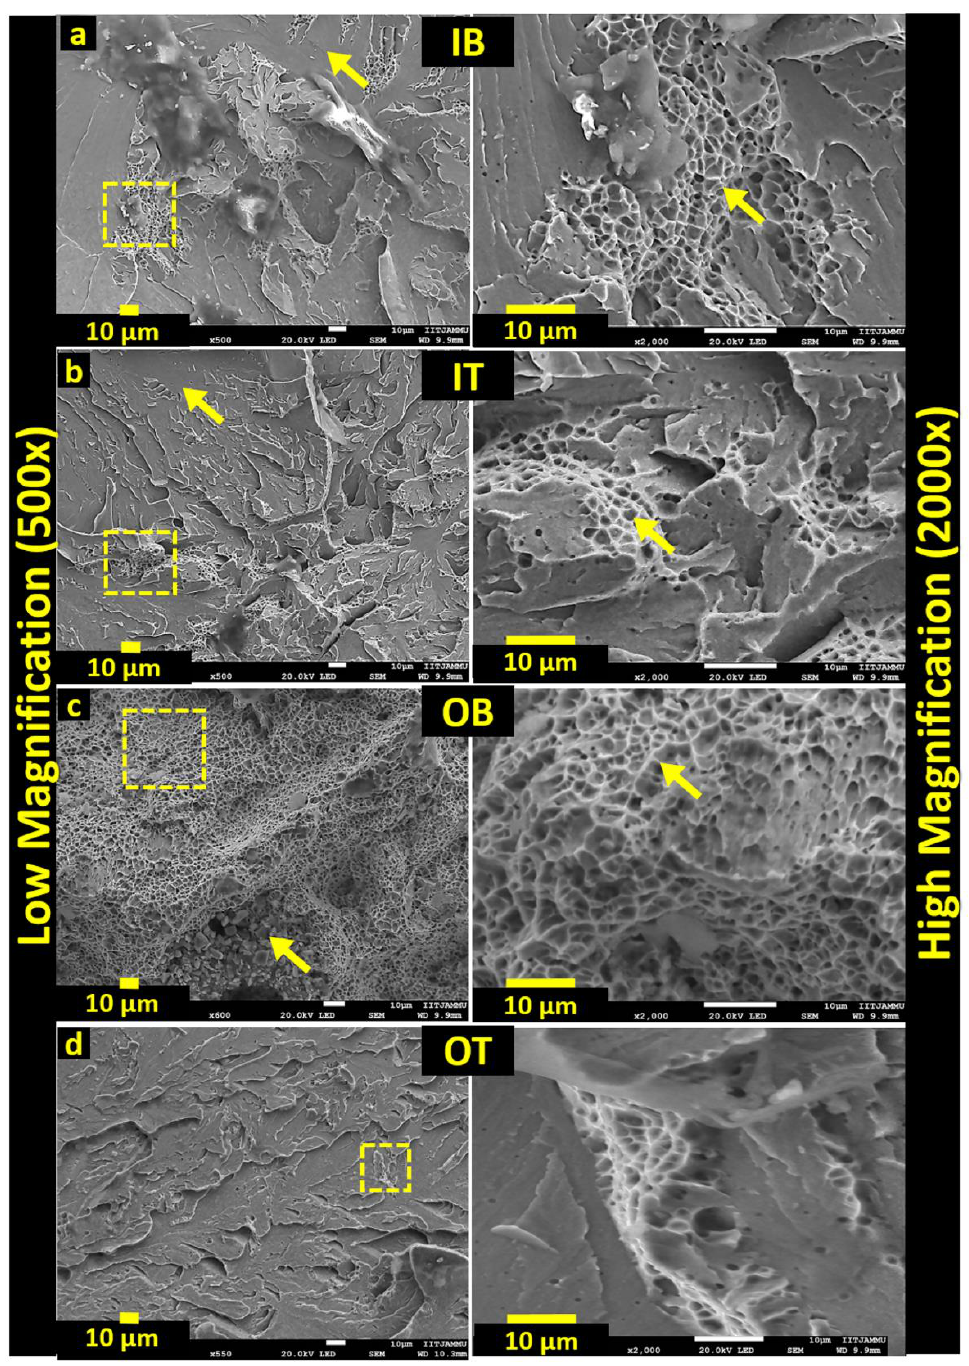
Figure 19. The fractography images of different samples including ( a ) IB, ( b ) IT, ( c ) OB, and ( d ) OT obtained with the aid of SEM at both low and high magnification.